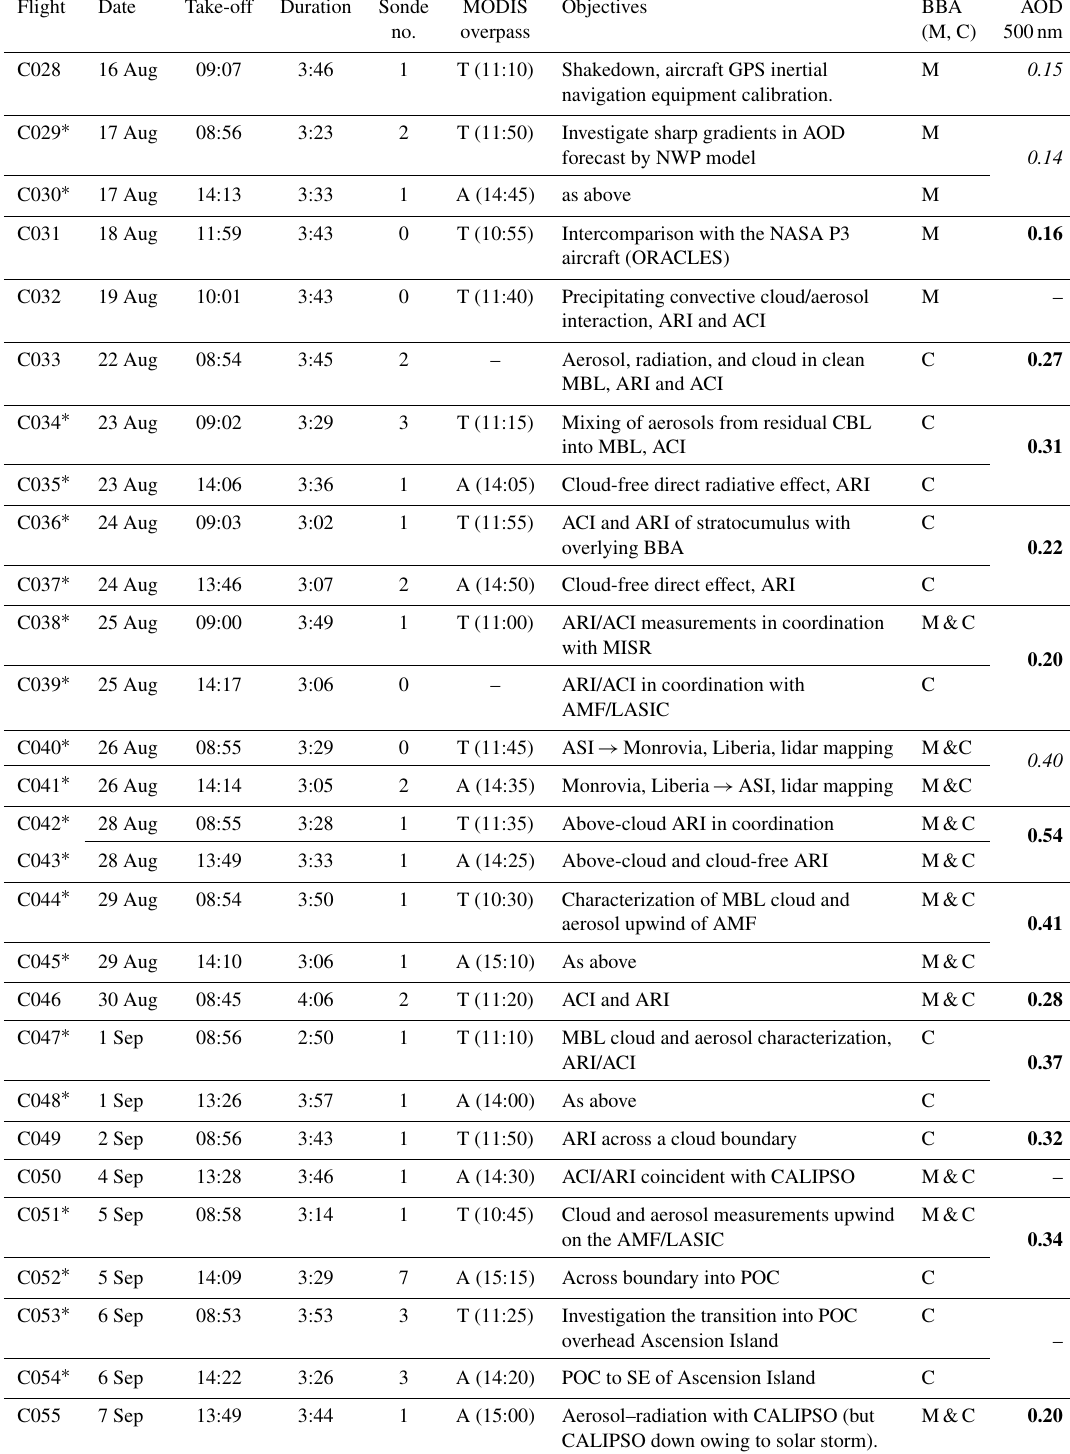
Table 2. Details of the flights performed during CLARIFY-2017 including take-off and landing times (GMT). ∗ is used to indicate flights that were part of a double-flight i.e. both in the morning and evening. M refers to BBA positions in the MBL, while C refers to BBA in the residual continental boundary layer. MODIS overpasses and timings are also shown (A is Aqua and T is Terra). The mean daily AOD at 500nm from AERONET stations is shown in italics, while values obtained from the handheld Microtops sun photometers are shown in bold. MBL is the marine boundary layer, CBL the continental boundary layer, MISR the Multi-angle Imaging SpectroRadiometer, CALIPSO the Cloud-Aerosol Lidar and Infrared Pathfinder Satellite Observations, and POC the pocket of open